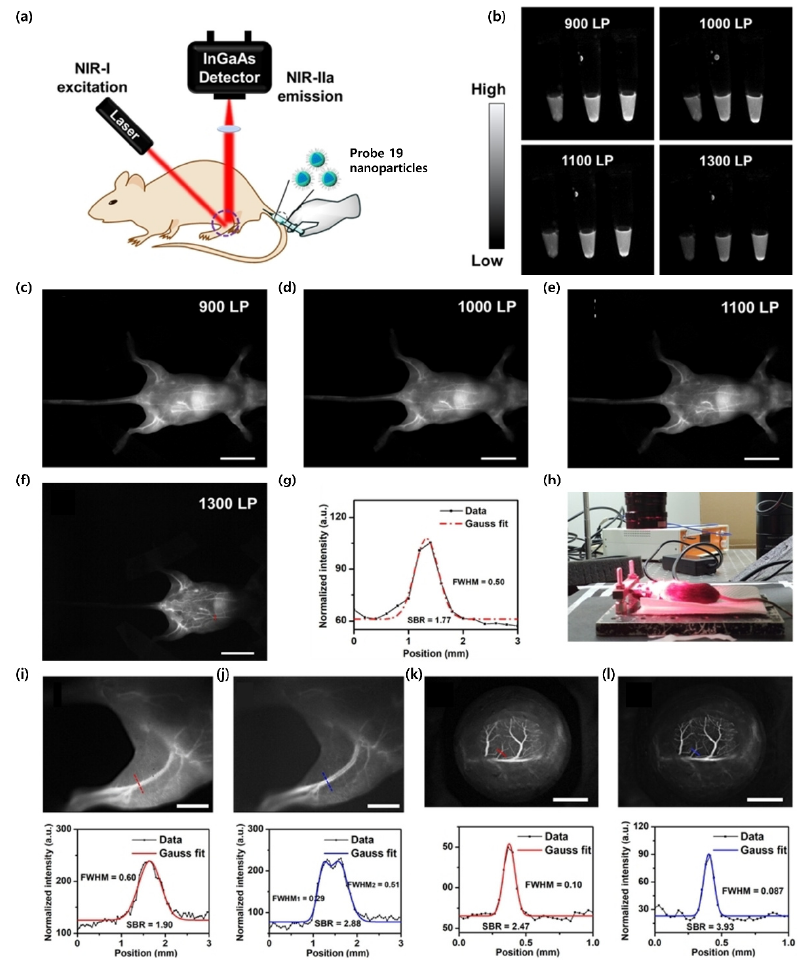
Figure 12. Probe 19 nanoparticle-based imaging in vivo. ( a ) Schematic illustration of NIR-II fluo- rescence imaging of the hindlimb vasculatures in BALB/c nude mice using a wide-field imaging system. ( b ) Comparison of NIR-II fluorescence signals at different concentrations with different LP filters (0.1, 0.25, and 0.5 mg mL − 1 ). ( c – g ) NIR-II images of the whole-body vessels of mice after intravenous injection of the probe 19 nanoparticles with F127 under irradiation with a 690 nm laser (200 µ L, 0.5 mg mL − 1 ). Scale bar = 2 cm. ( h ) Photographs of the devices and instruments used in hindlimb and brain blood vessel imaging experiments. ( i ) NIR-II and ( j ) NIR-IIa fluorescence images of the hindlimb blood vessels of nude mice using 1100 nm and 1300 nm LP filters, respectively. Scale bar = 5 mm. ( k ) NIR-II and ( l ) NIR-IIa fluorescence images of the brain blood vessels during craniotomy in C57BL/6 mice using 1100 nm and 1300 nm LP filters, respectively. (Scale bar = 3 mm). Reprinted with permission from Ref. [116]. Copyright 2021, John Wiley and